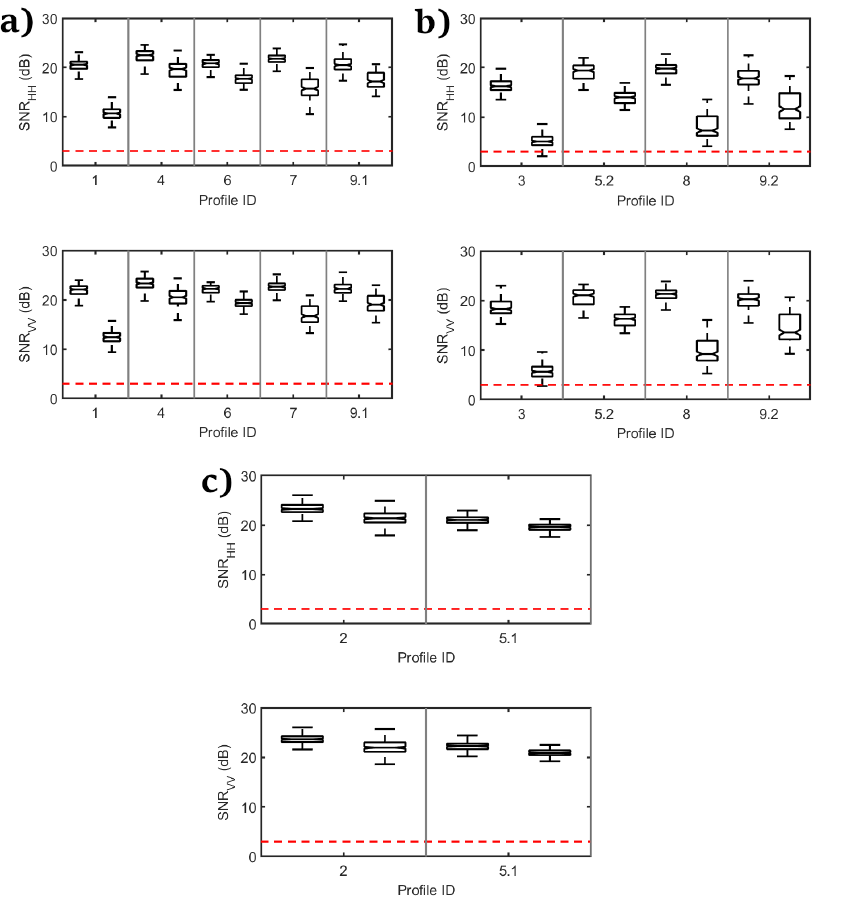
Figure 9. SNR values presented in the format of box plot for both HH- and VV-intensity, respectively, upper and lower panels. For each profile, the classes are divided in IW crest (left) and troughs (right): ( a ) double sign IW signatures; ( b ) single-negative sign IW signatures; and ( c ) single-positive sign IW signatures. Please note that, for each box plot, the horizontal line inside the box represents the median SNR values and its first and third quartiles are represented by the lower and upper line of the box. The minimum and maximum SNR values excluding outliers are represented by the lower and higher short horizontal bars. The dashed red line represents the 3 dB SNR